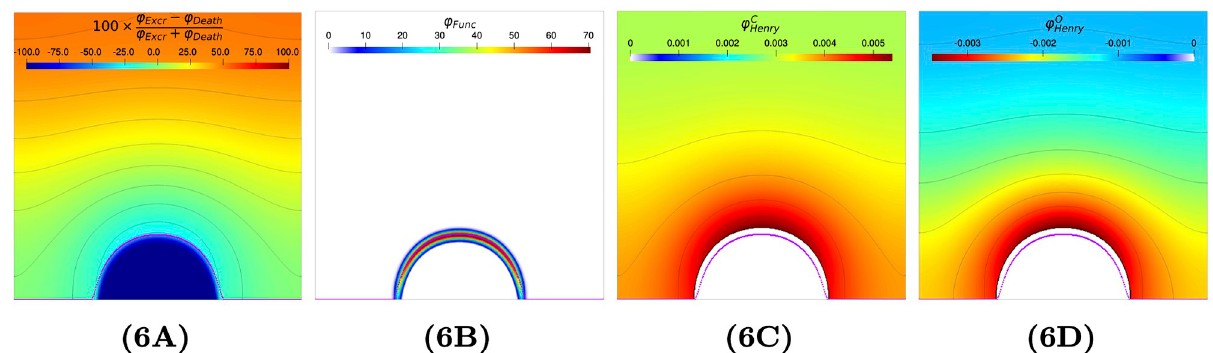
Fig 6. Relative difference between excretion and death rates, functional biomass production, inorganic carbon transfer rate and oxygen ransfer rate at day 15 (see S2 Text for the expression of these terms). Fig 6A: Relative difference ( Δ in %) between fluxes for ECM excretion and death. Fig 6B: Functional biomass production rate φ Func . Fig 6C: Inorganic carbon supply φ C